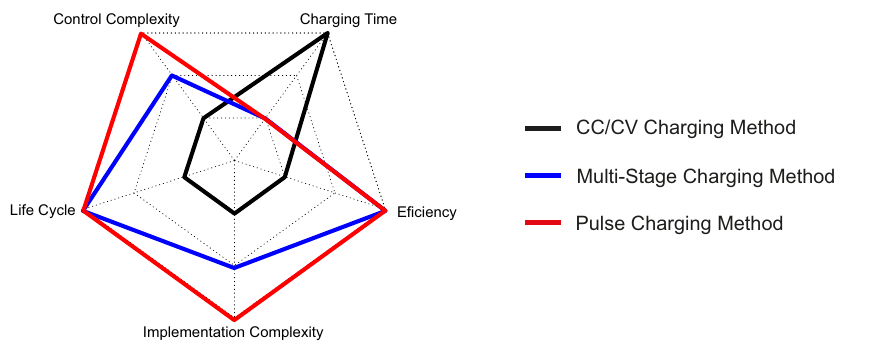
Figure 4. Comparison of charging methods.